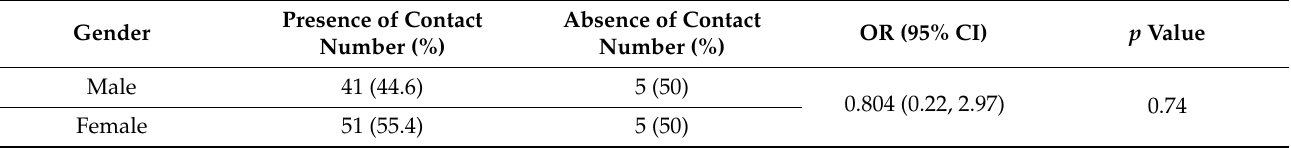
Table 1. Correlation of gender with the contact of the IMTM root with the MC. Gender